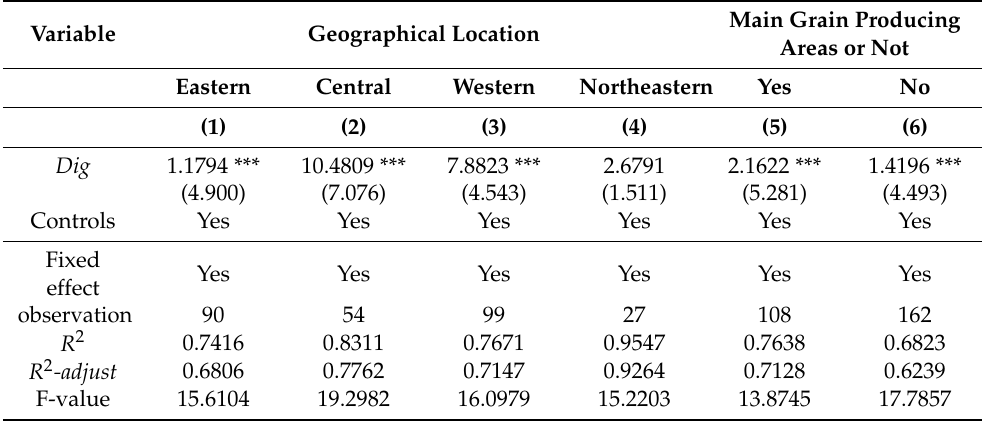
Table 11. Regression results of regional